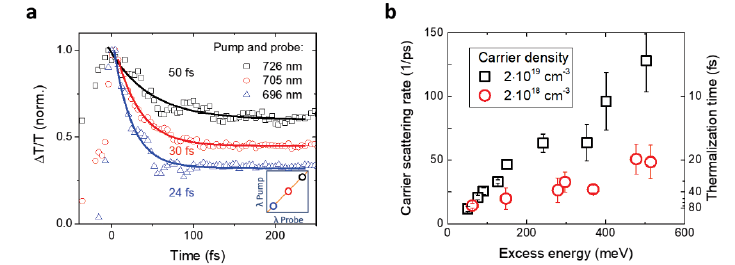
Fig. 2. (a) Pump wavelength dependence of the kinetics of the diagonal peaks in the 2DES maps at an excitation density of 2x10 19 cm −3 . The shorter the pump wavelength, the faster the diagonal decays. (b) Carrier scattering rate vs. excess energy over the bandgap at 1.63 eV. The scattering rates increase with excess energy and show a fluence